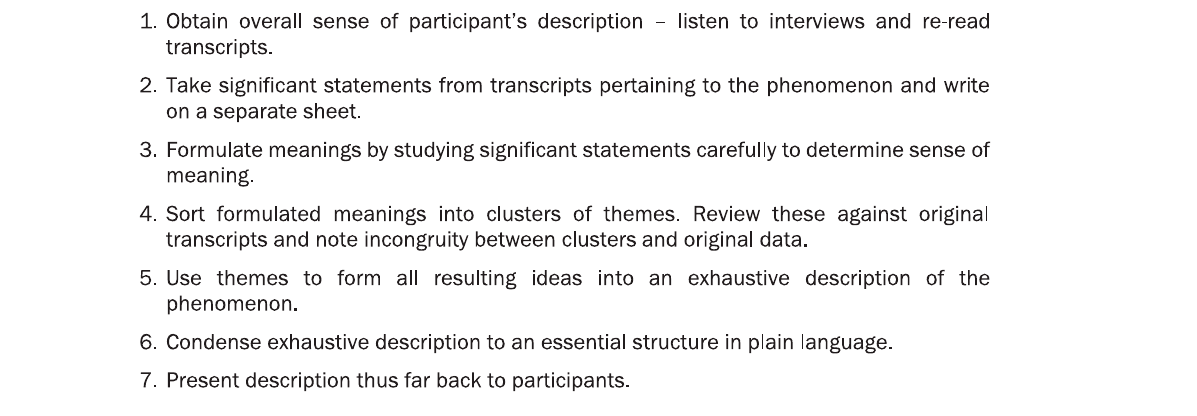
FIGURE 2 | Colaizzi’s method